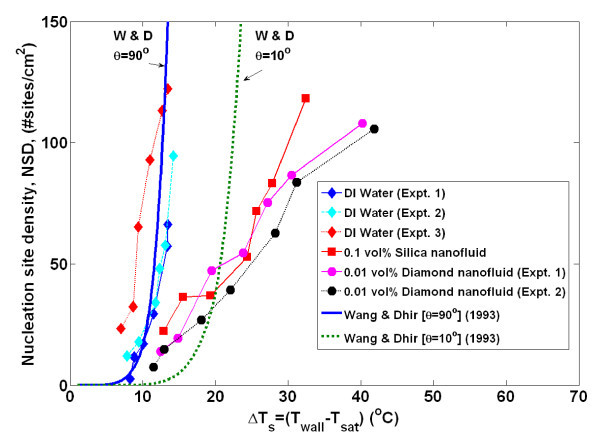
Active nucleation site density as measured by infrared thermometry. Uncertainty in nucleation site density is ≤2%.